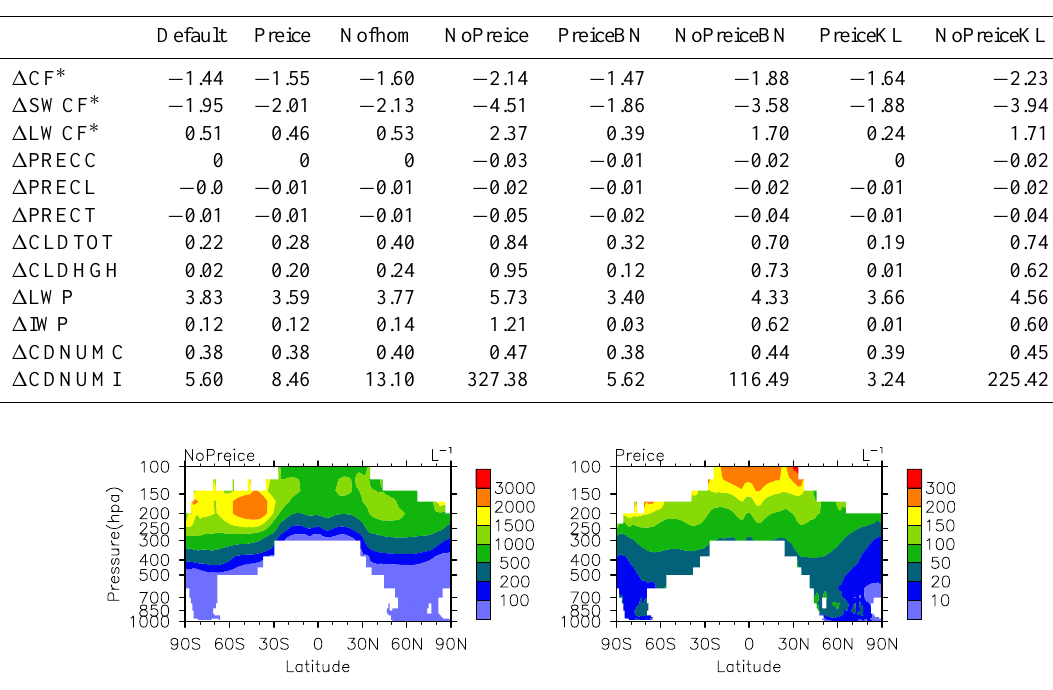
Figure 7. Annual zonal mean in-cloud ice crystal number concentration ( N i , L − 1 ) from NoPreice (left) and Preice (right) experiments. Note the different color bars. Results are sampled from model grids where annual mean occurrence frequency of ice nucleation events is greater than